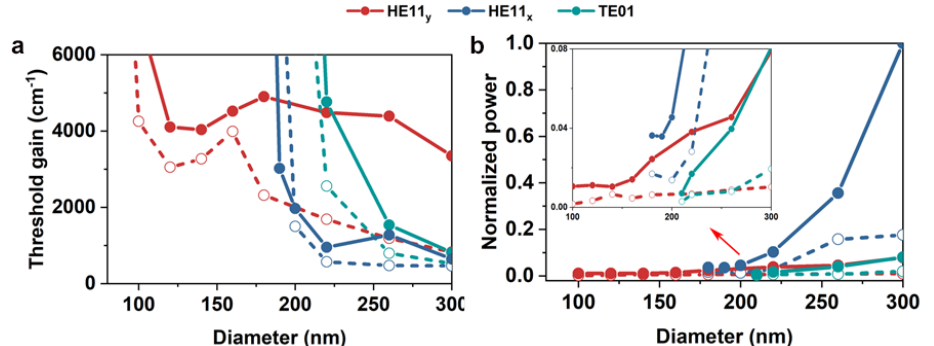
Figure 6. ( a , b ) Threshold gain and normalized output power for SPP (solid lines) and SPPG (dash lines) lasers. The inset in ( b ) infers the normalized output power of HE11 y mode.